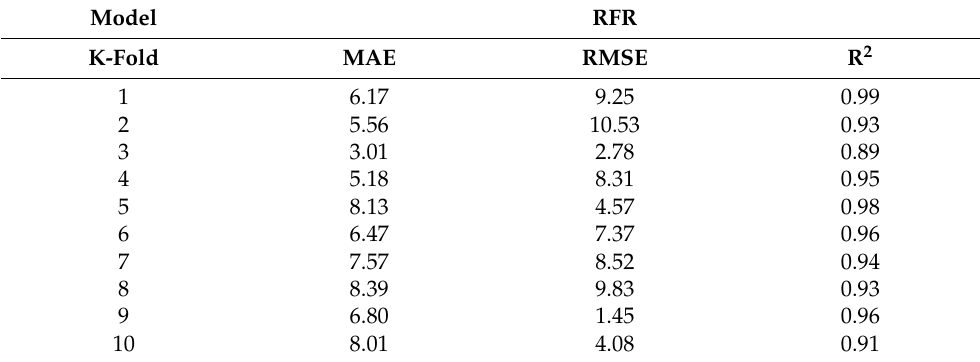
Table 6. Cross-validation results of the RFR model with statistical measures.